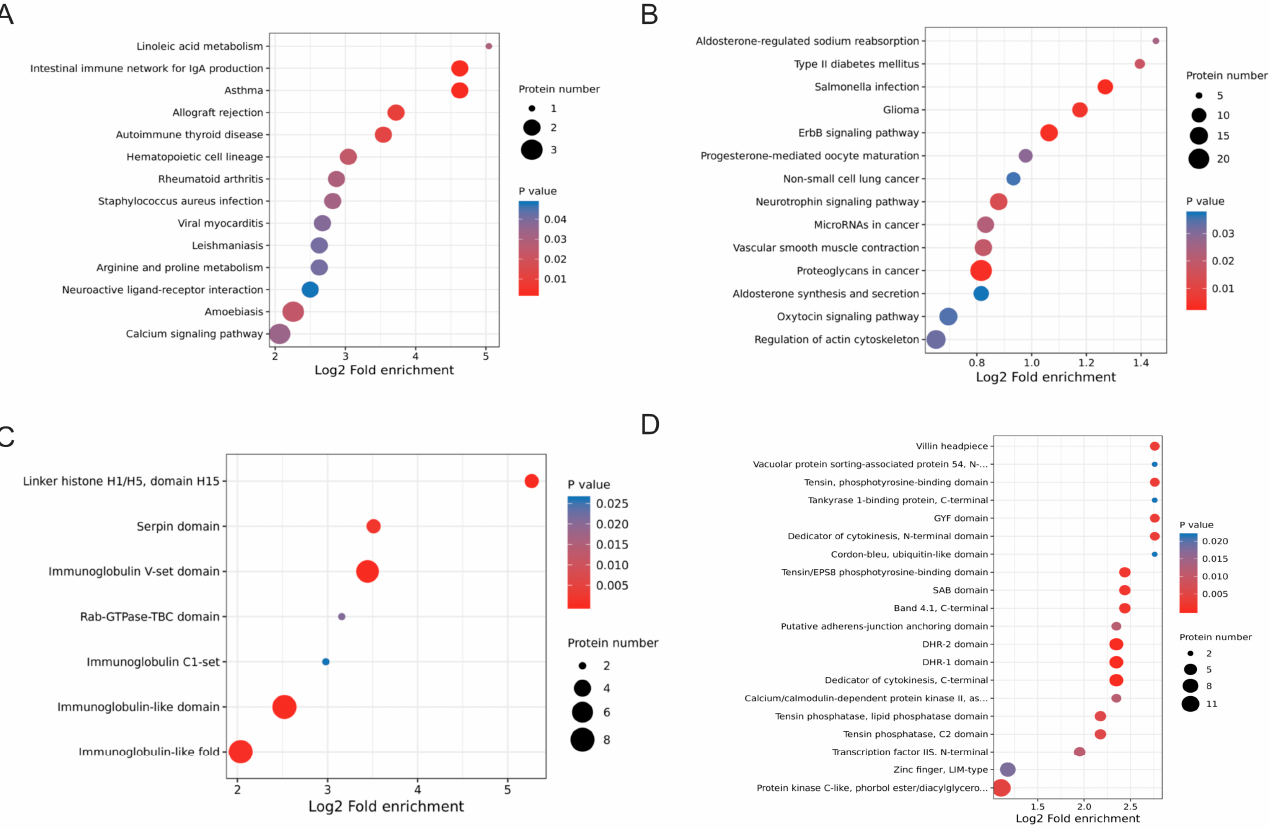
Figure 6. KEGG pathways and protein structural domain enrichment analysis of DEPs and